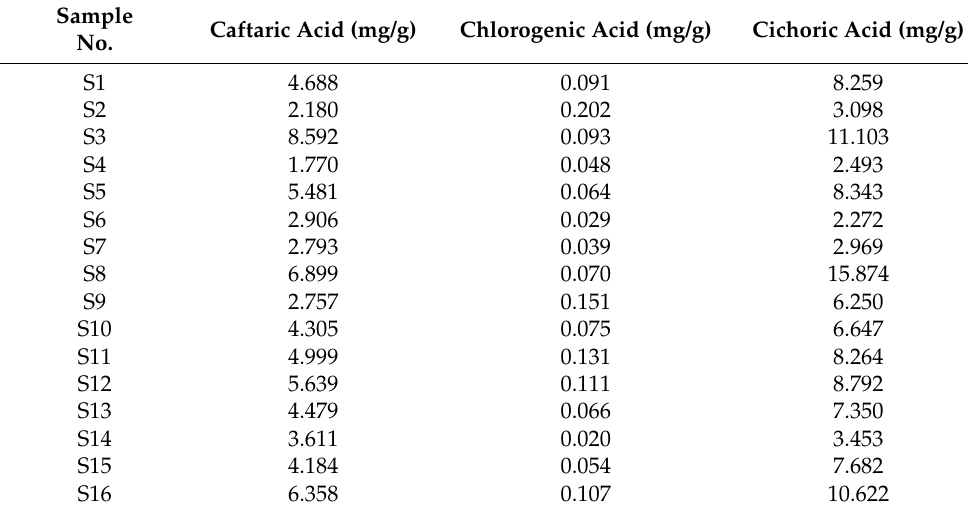
Table 5. Contents of 3 components in samples of Echinacea pupurea (L.) Moench from different origins ( n = 3,